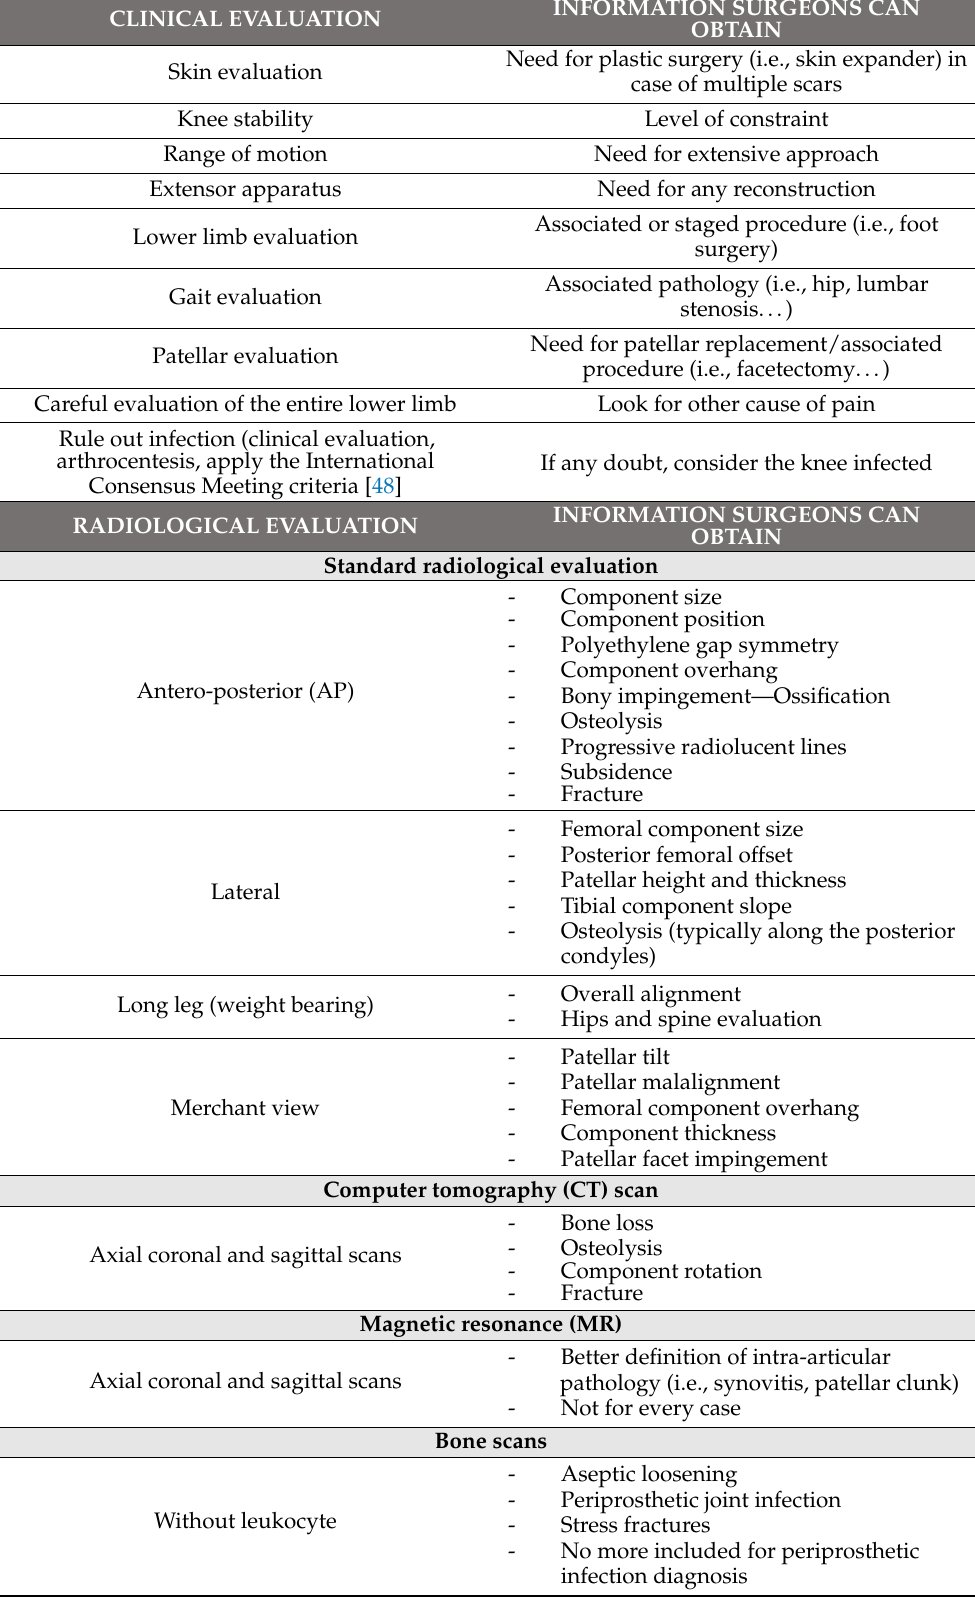
Table 2. Summary of information available to the surgeons with standard pre-operative planning for revision